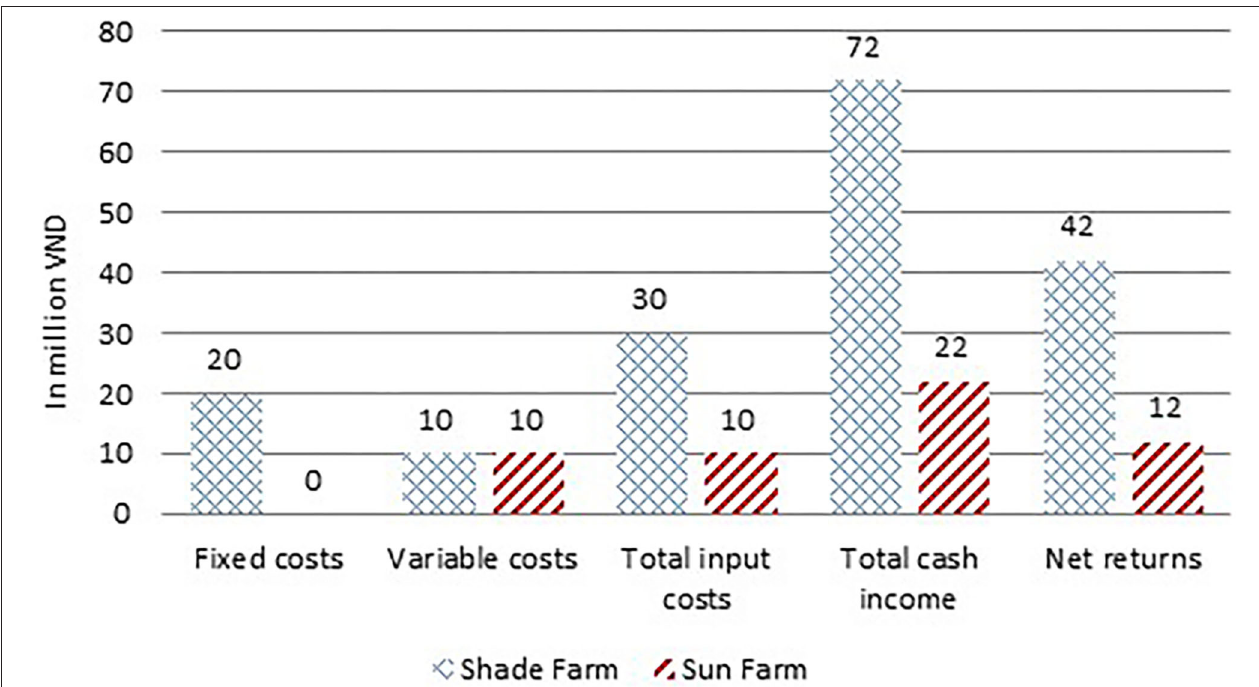
FIGURE 5 | Comparative costs and returns between shade farm vs. sun farm 2018–2019 Harvest. Exchange rate: VND 23,000 = USD 1. Based on 4,000 m 2 of land in each farm. Net returns = Total cash income – Total input costs. Total input costs = Fixed costs + Variable Costs.